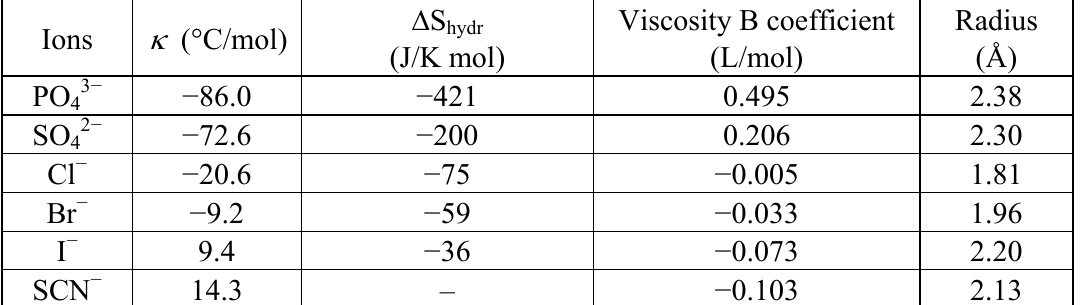
Table 2. Linear correlation between  of the fitted curves and the entropy of hydration ( Δ S ), viscosity B coefficient of the anions, the anion radius. Note: Δ S hydr coefficient, and anion radius are from reference